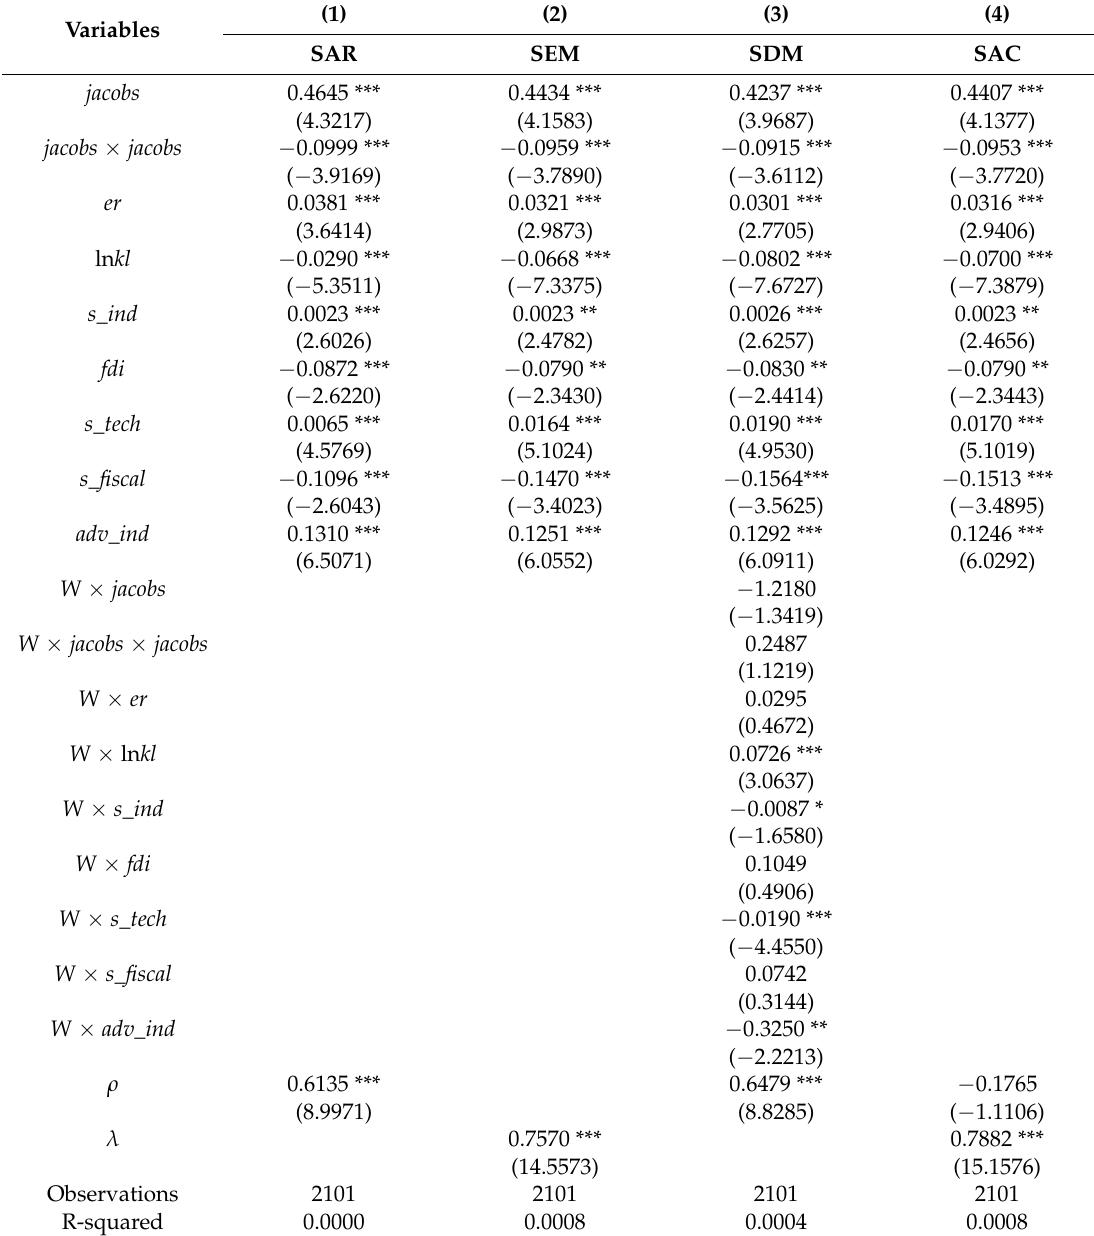
Table 5. Spatial effects of Jacobs externality on